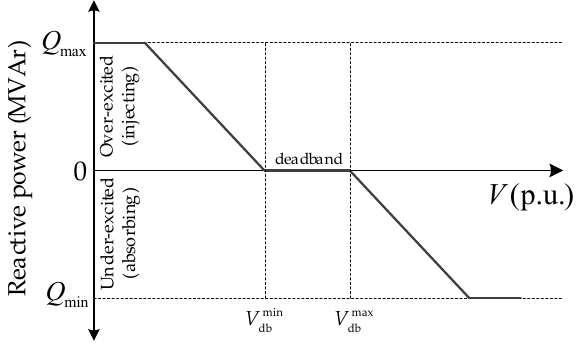
Figure 2. Smart inverter control based on Q(V) − characteristic.